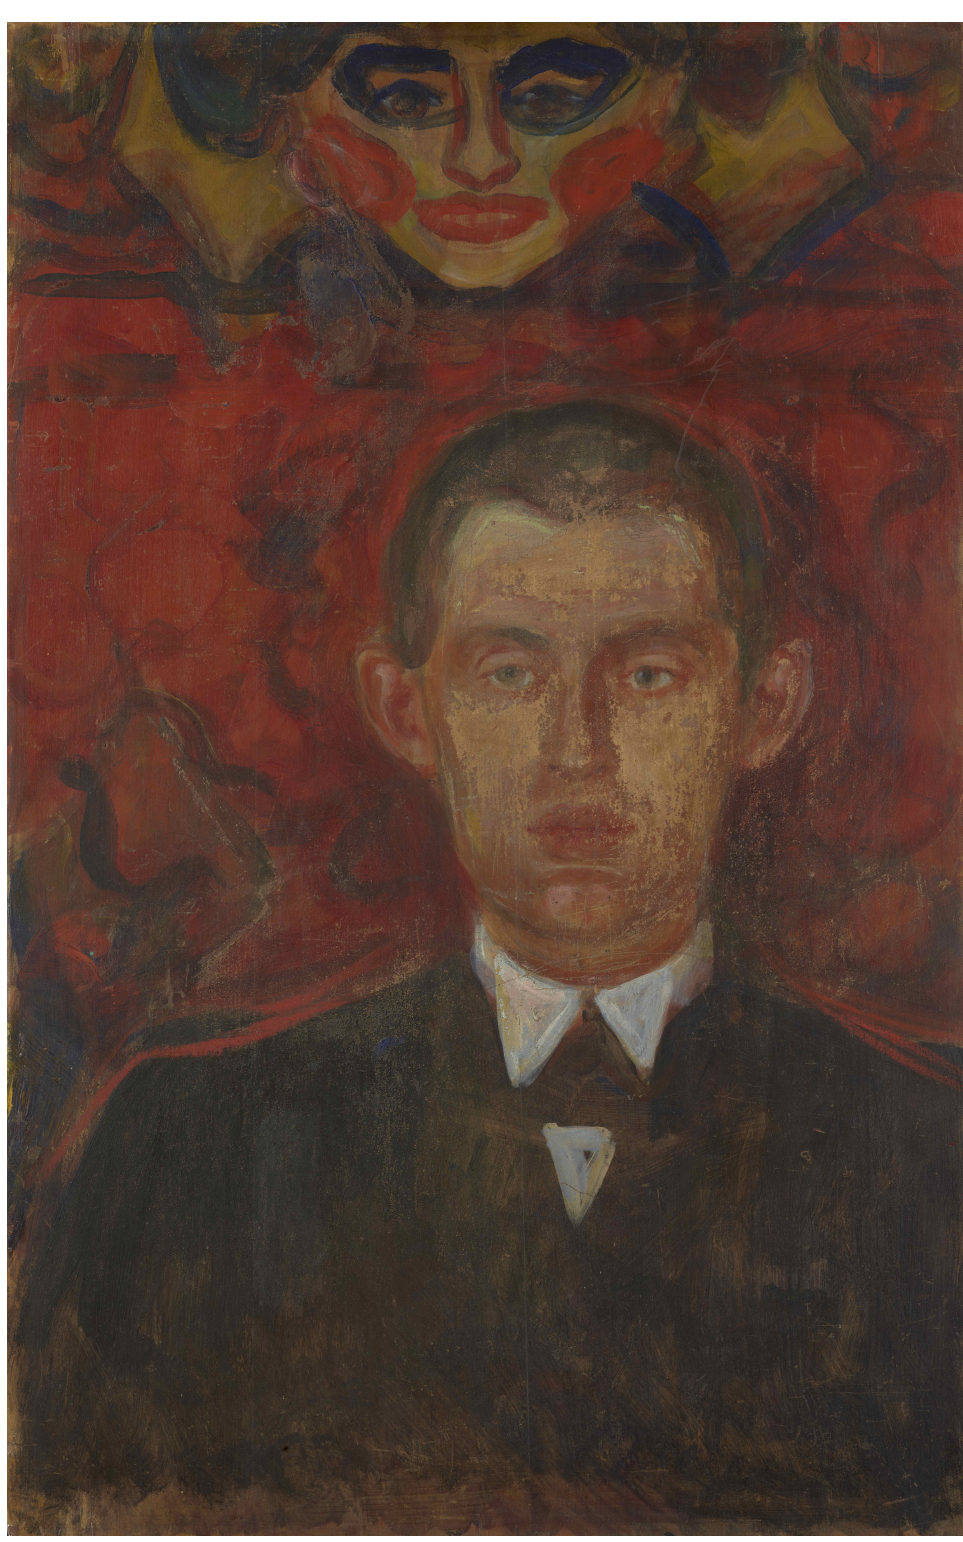
Figure 5: Self-portrait under the Mask of a Woman (1893) ©